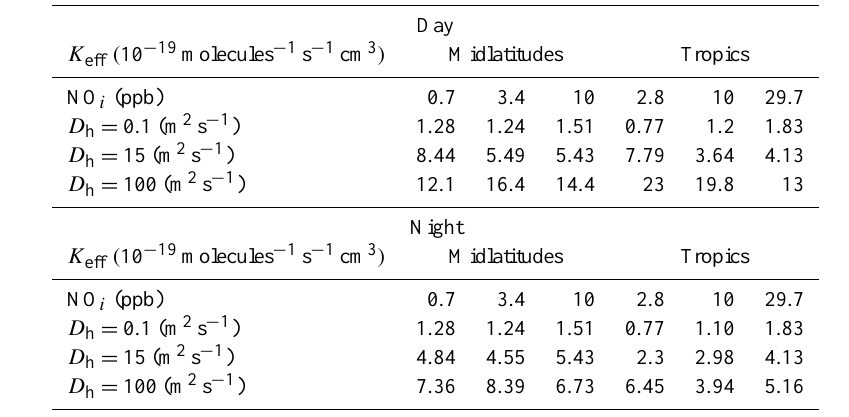
Table 3. The effective reaction rate constant K eff (10 − 19 molecules − 1 s − 1 cm 3 ) in the midlatitudes and tropics depending on the initial NO mixing ratio injected by lightning emissions (NO i , ppb) and the horizontal diffusion coefficient ( D h , m 2 s − 1 ) for day (upper part of table) and night conditions (bottom part of table).